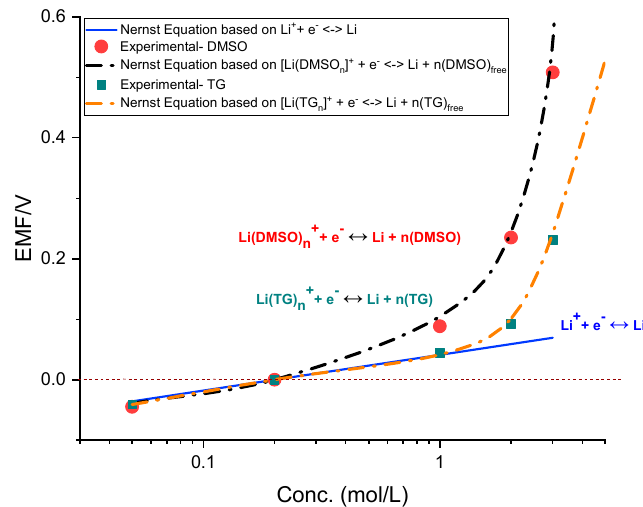
Figure 2. Reference potential measurement compared to the theoretical calculations for different concentrated solutions of DMSO and TG.